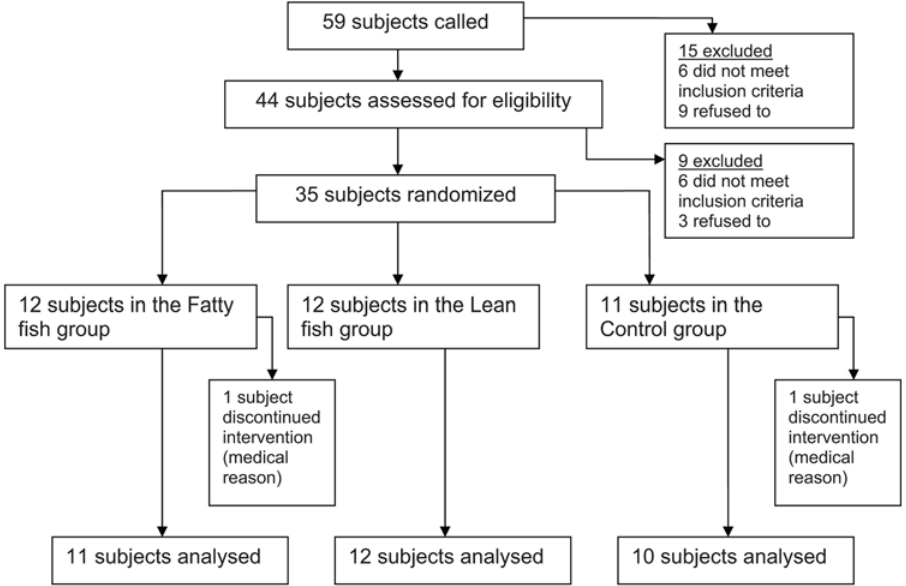
Figure 1. The CONSORT flow diagram.